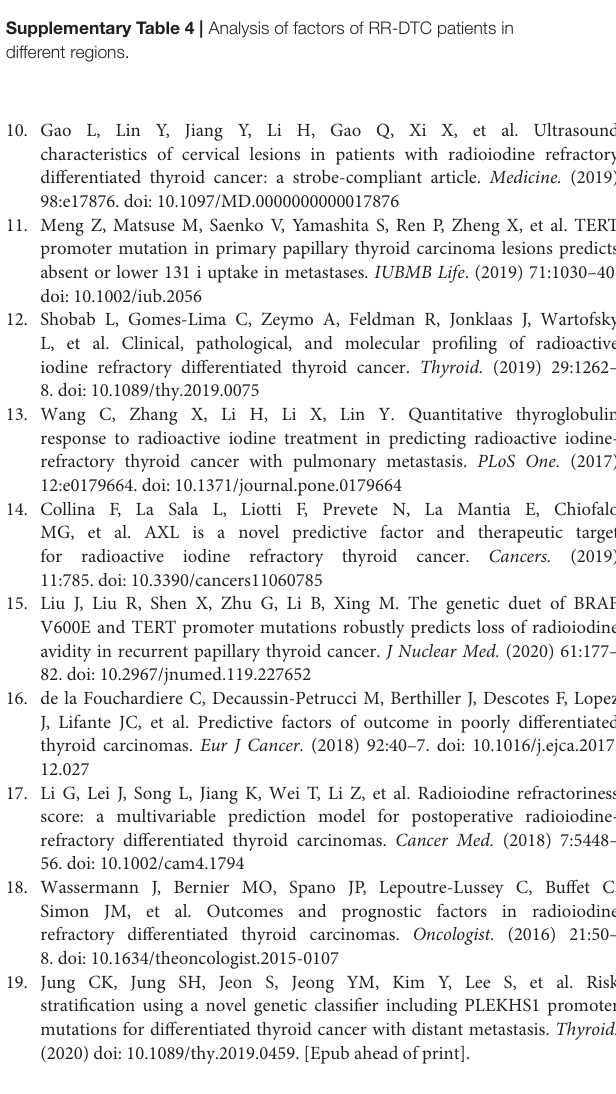
(D) , histological subtype (E) , extrathyroidal extension (F) , lateral lymph node metastasis (G) , BRAF V 600 E mutation (H) , and TERT promoter mutation (I) . Supplementary Table 1 | Quality of eligible studies (Newcastle-Ottawa Scale). Supplementary Table 2 | Analysis of the categorical variables for patients with RR-DTC. Supplementary Table 3 | Analysis of the continuous variables for patients with RR-DTC. Supplementary Table 4 | Analysis of factors of RR-DTC patients in different